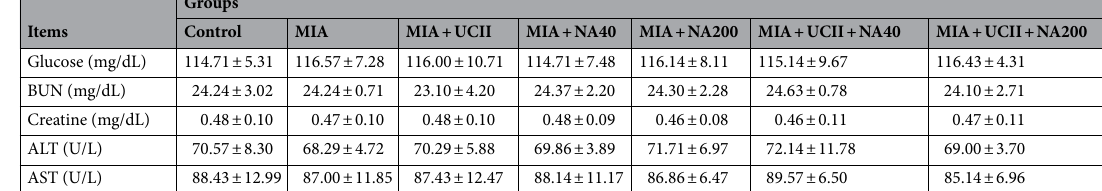
Table 3. Effects of niacinamide (NA) and undenatured type II collagen (UCII) on serum biochemical parameters in rats (n = 7). Data are presented as mean and standard deviation ( p > 0.05; ANOVA and Tukey’s post-hoc test). NA: niacinamide; MIA: monosodium iodoacetate; UCII: undenatured type II collagen; BUN: Blood urea nitrogen; ALT: Alanine aminotransferase; AST: Aspartate aminotransferase. NA40 and NA200 represent 40 and 200 mg/kg niacinamide dose applications, respectively.